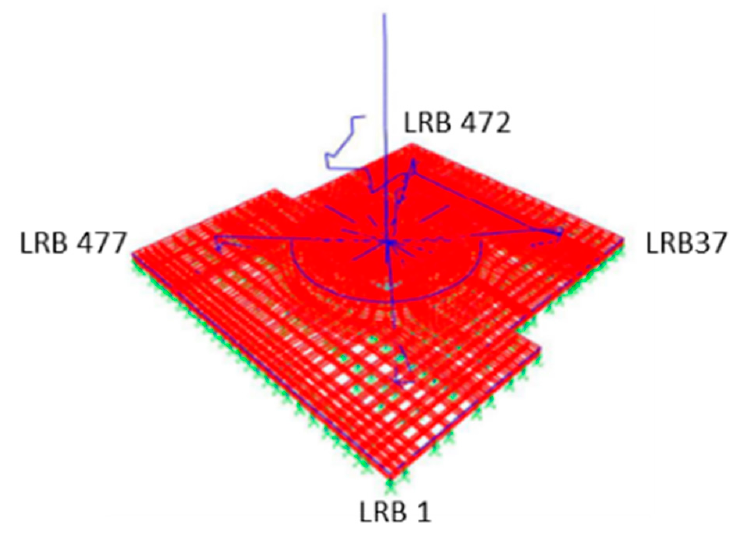
Table 1. Comparison of modal frequencies between SAP2000 and OpenSees models.